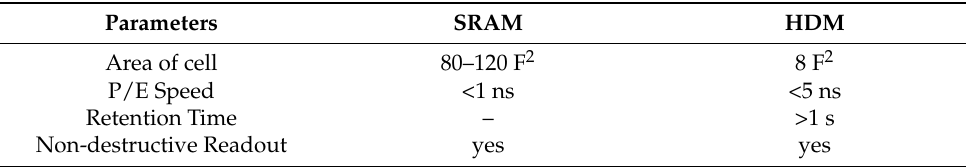
Table 2. The compared benchmarks of SRAM and the HDM